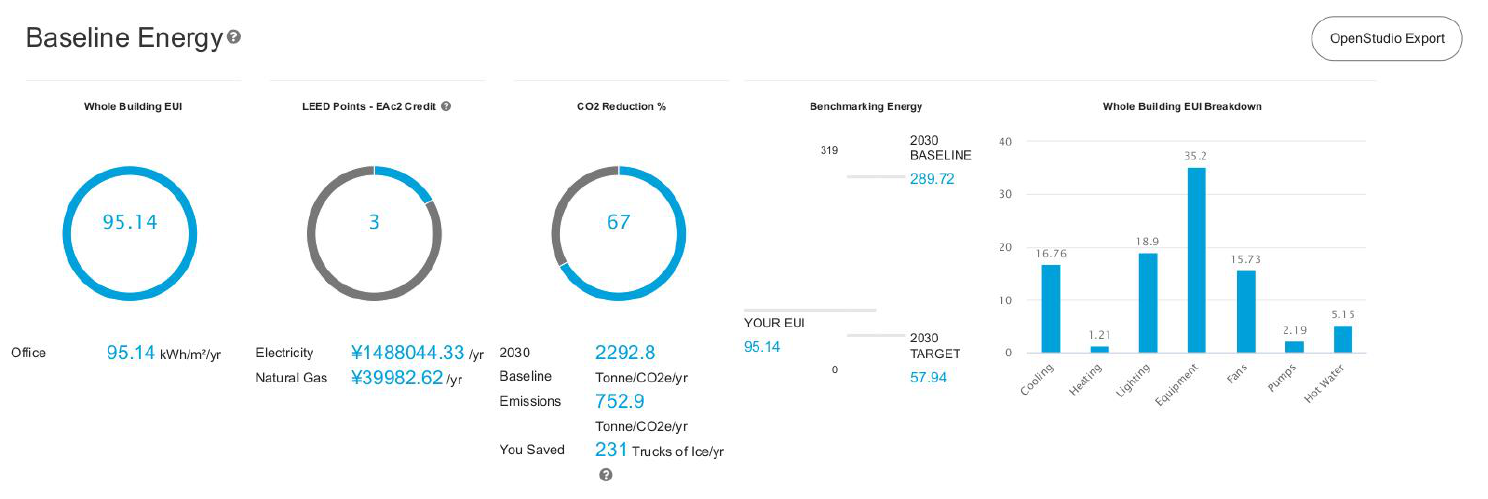
Figure A4. Zone 2-A Guangzhou, Guangdong (pre-COVID-19 scenario).